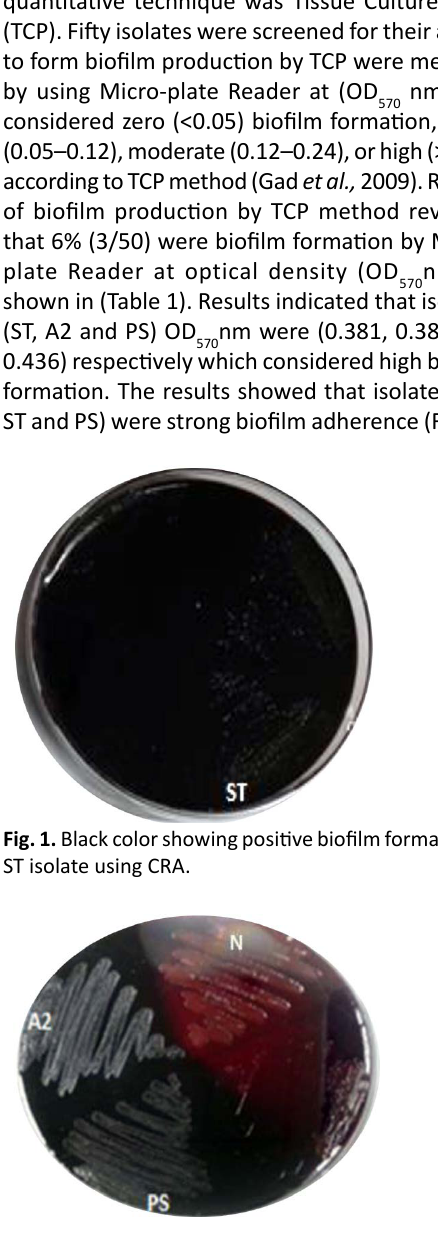
Fig. 2. Black color showing positive biofilm formation of A2 and PS isolate. Using CRA. While N: negative pink color for (non-biofilm